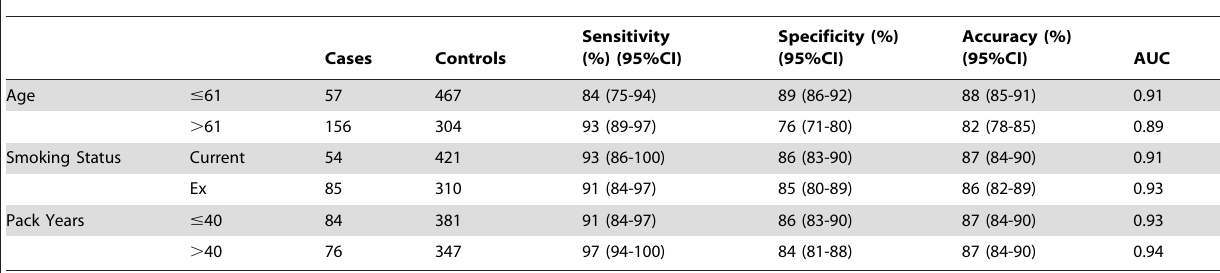
Table 8. Performance of classifier in demographic subsets.